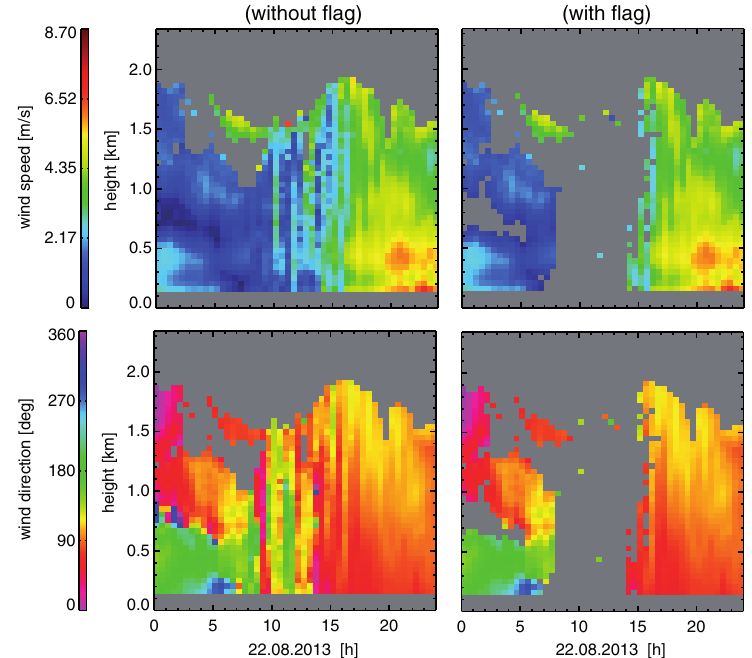
Figure 4. Left column: example of non-quality assured wind profile retrievals (top: wind speed, bottom: wind direction) from Doppler lidar measurements for a typical summer day (22 August 2013). Each profile represents a 30min average of VAD Doppler lidar measurements with one scan lasting about 3min. Right column: same wind retrievals as shown in the left column but where profiles with test parameters R 2 < 0 . 95 and CN > 10 have been